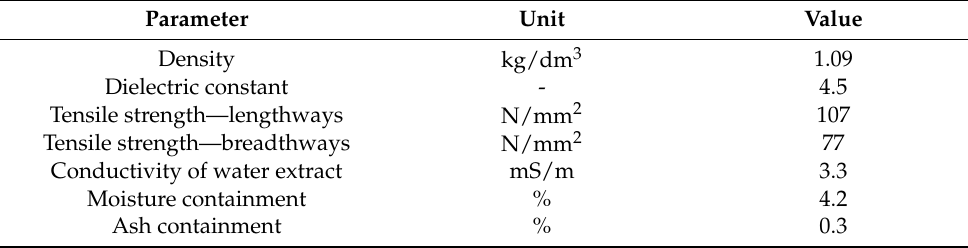
Figure 2. The model electrode system for the oil wedge considered in this study.